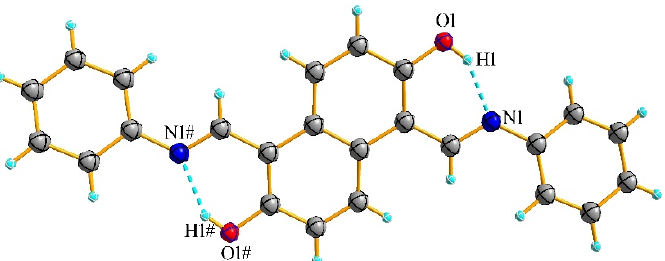
Figure 8. The X-ray single crystal diffraction image of probe L (Dashed lines represent hydrogen bonds, Symmetry code:# = − x , 1 − y , 1 − z ).